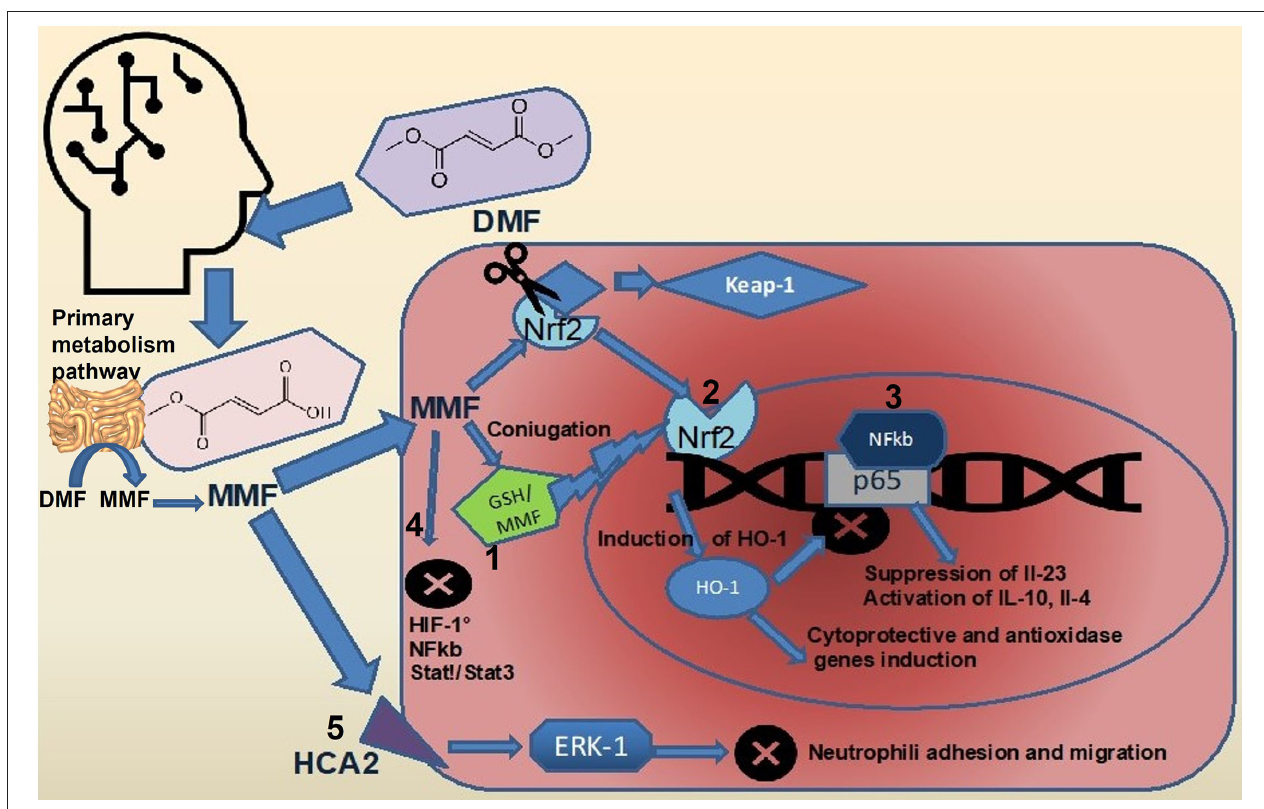
FIGURE 1 | Effects of DMF on intracellular signaling pathways. Upon ingestion, most of the DMF (about 90%) is rapidly converted to MMF by hydrolization in the small intestine ( 5). The full pharmacokinetic profile of DMF and MMF remains to be elucidated. DMF, dimethyl fumarate; MMF, monomethil fumarate; FAEs, fumaric acid esters; GP, glutathione peroxidase; GST, glutathione-S transferase; NF-kappaB, nuclear factor-kappa B; Nrf2, nuclear factor (erythroid-derived 2)-like 2; ROS, reactive oxygen species; and TCA, tricarboxylic acid